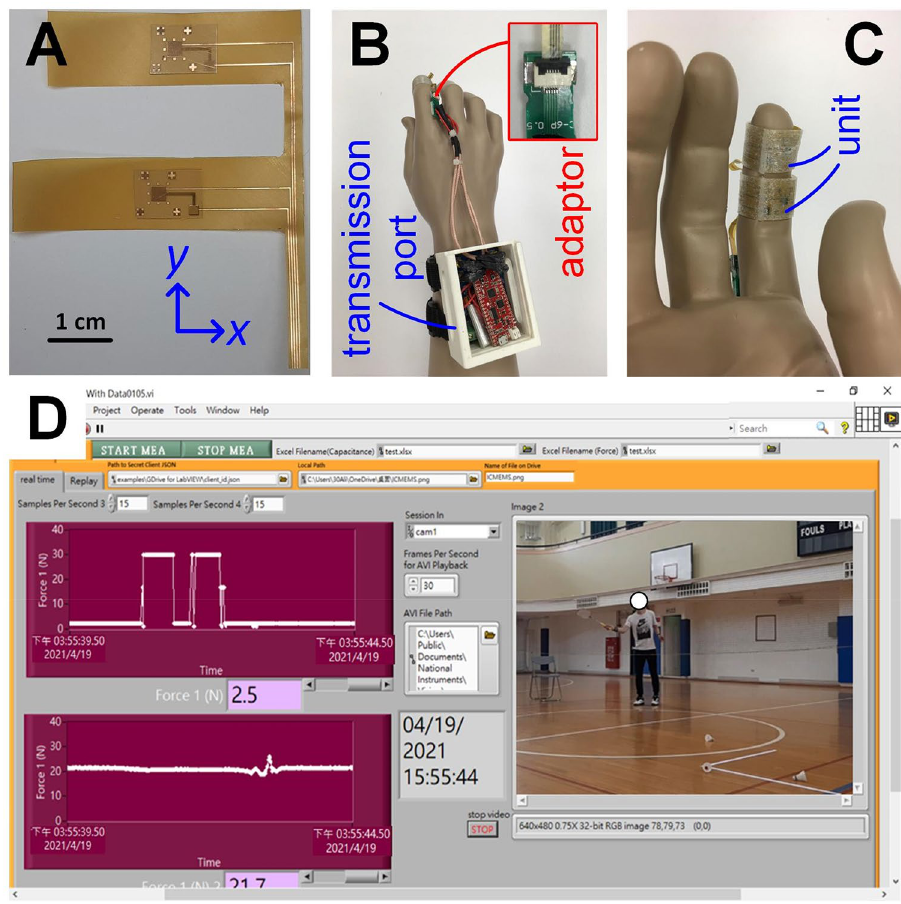
Figure 5. The fabricated ( A ) dual-channel sensing units that contain identical materials, dimensions, and structures; and ( B ) wearable demonstration with the transmission port (3.8 × 6.2 × 7.8 cm 3 ) that contains a Li-ion battery, a capacitance-to-digital signal converter, and a Bluetooth module on a plastic model hand through an adaptor (inset) with ( C ) close-up look of the sensors from the finger pulp side. ( D ) The